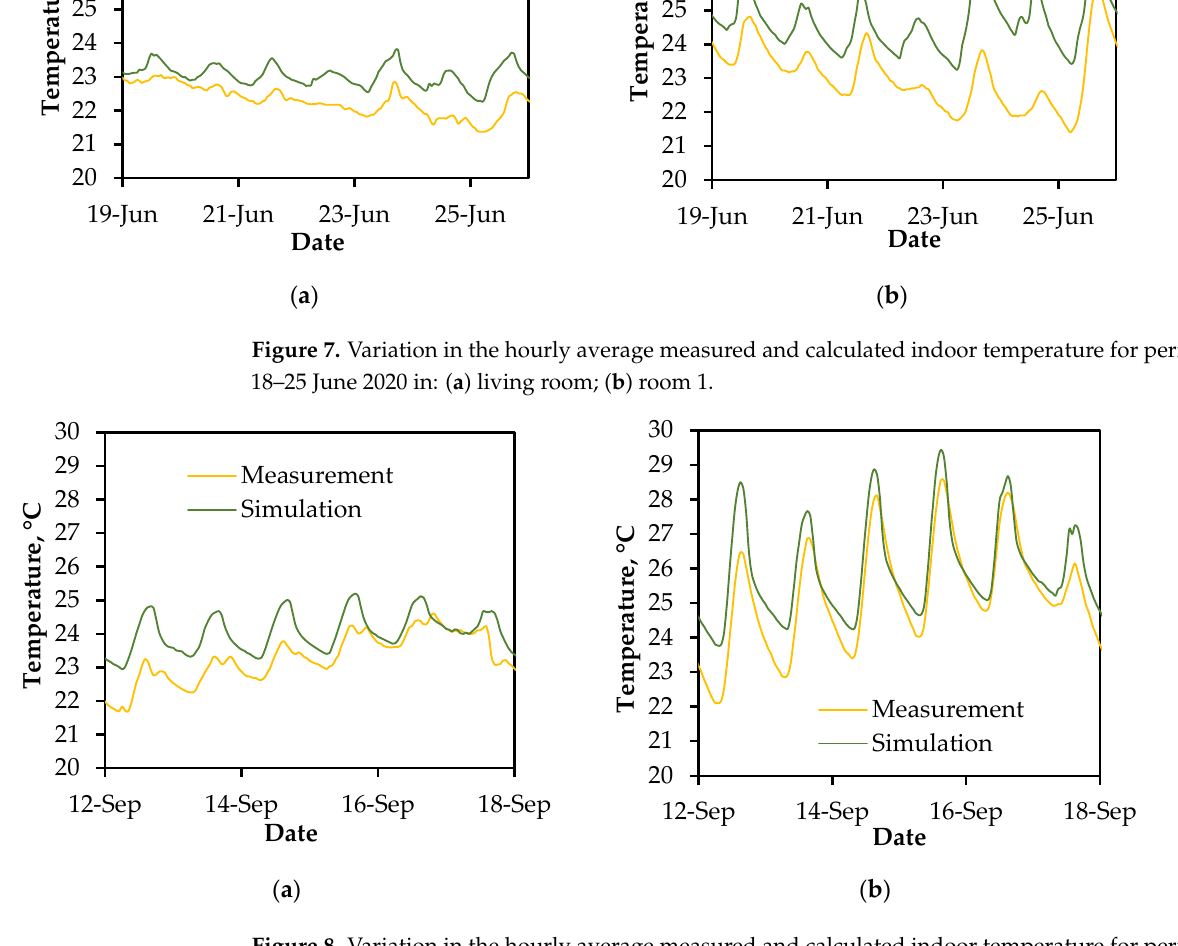
Figure 8. Variation in the hourly average measured and calculated indoor temperature for period of 12–17 September 2020 in: ( a ) living room; ( b ) room 1. Table 3. Correlation coefficients R for measured and calculated hourly values of indoor temperature for periods without occupants.